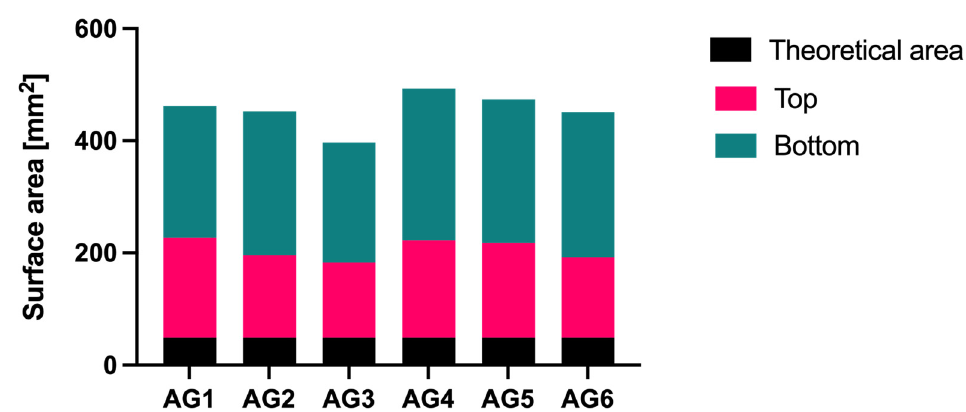
Figure 5. The surface area of the alginate-gelatin samples, AG1 (control), AG2 (Al 2 O 3 ), AG3 Figure (Na 2 Ti 6 O 13 ), AG4 (TiO 2 ), AG5 (ZrO 2 ), and AG6 (WO 3 ).